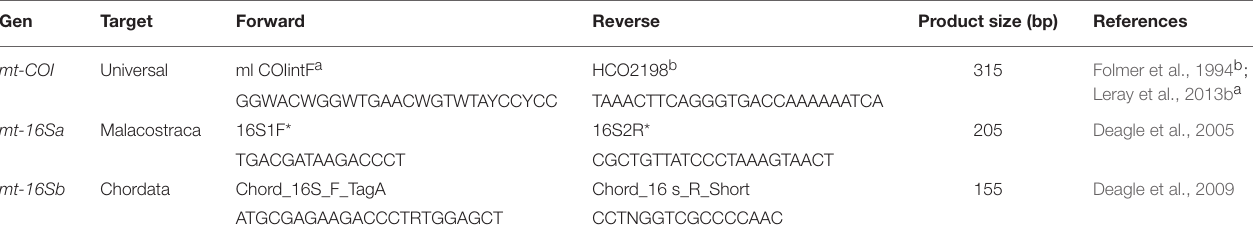
TABLE 1 | All of them amplify different regions of mitochondrial (mt) DNA. Product size (bp): Approximate product size of each PCR product (without overhang) expressed as number of base pairs